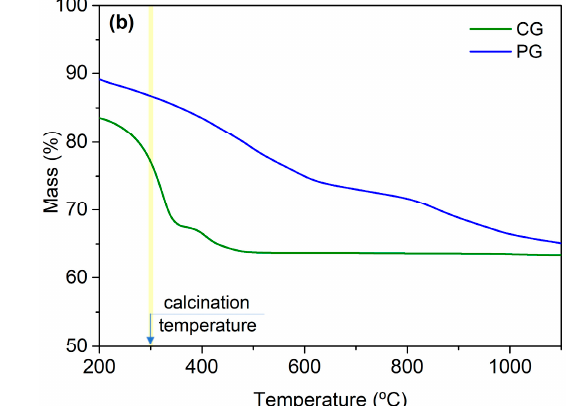
Figure 4. Thermograms of the obtained powders: ( a ) DTA; ( b ) TGA.